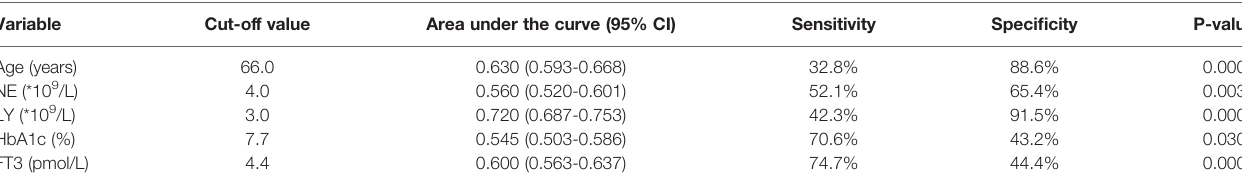
TABLE 2 | The ROC curve analysis of continuous variables with statistical signi fi cance. Variable Cut-off value Area under the curve (95% CI) Sensitivity Speci fi city P-value Age (years)